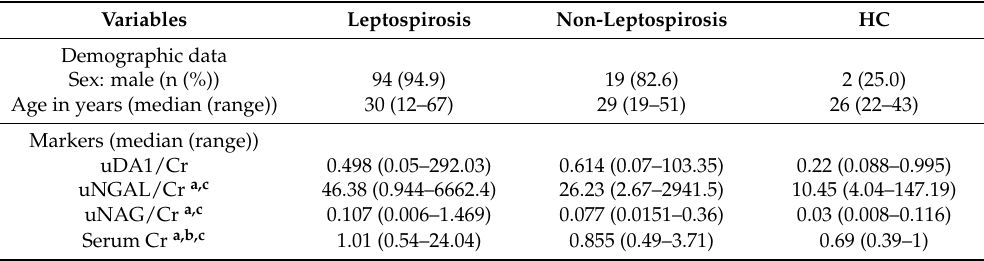
Table 1. Basic and clinical characteristics of the study